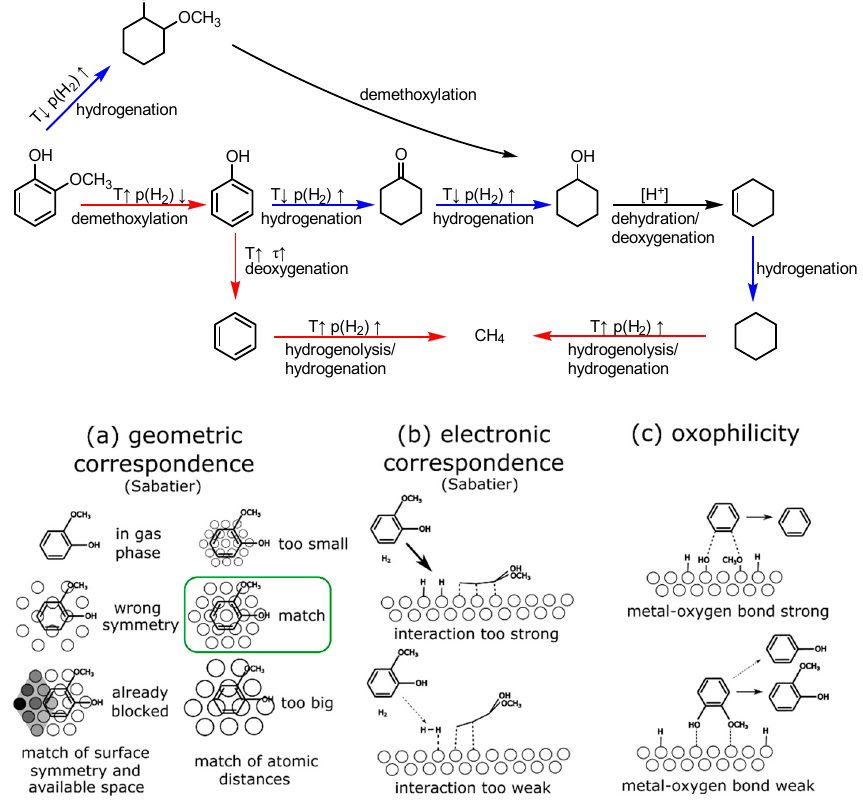
Figure 1. Schemes of (top) the reaction routes and individual reaction steps for the hydrodeoxygenation of guaiacol and (below) the mechanistic backgrounds of ( a ) geometric correspondence for reactant and metal surface, ( b ) electronic correspondence for hydrogen activation and transfer to the reactant according to the Sabatier principle, and ( c ) oxophilicity of the metal surface affecting its reactivity [23,26,33,35–39].